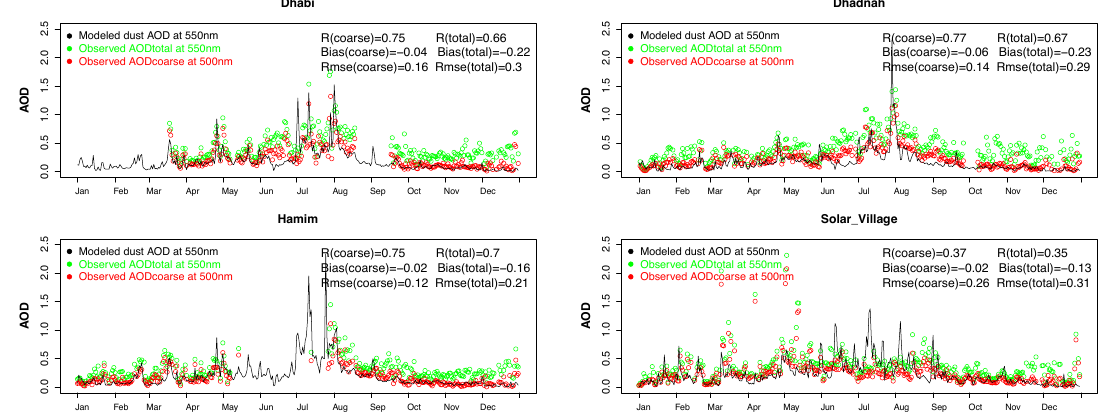
Fig. 6. Daily AOD average of model vs. AERONET stations in the Middle East (Dhabi, Dhadnah, Hamim and Solar Village) for 2006. Model averages (black lines) represent the dust AOD at 550nm. Observations include AODtotal (green circles) and AODcoarse (red circles).Each panel includes the correlation ( R ), bias and root mean square error (RMSE) between the model and AODcoarse and AODtotal. Mali/Mauritania Border appear to be misrepresented